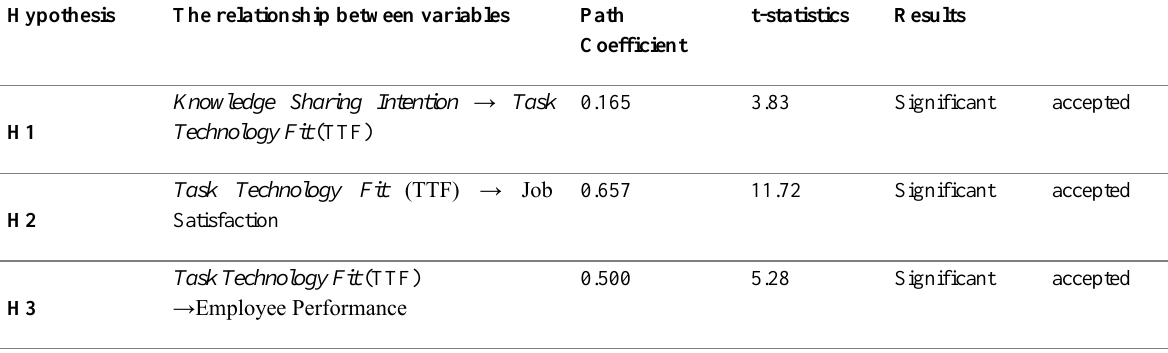
Table 2: Results of Hypothesis Testing for Direct